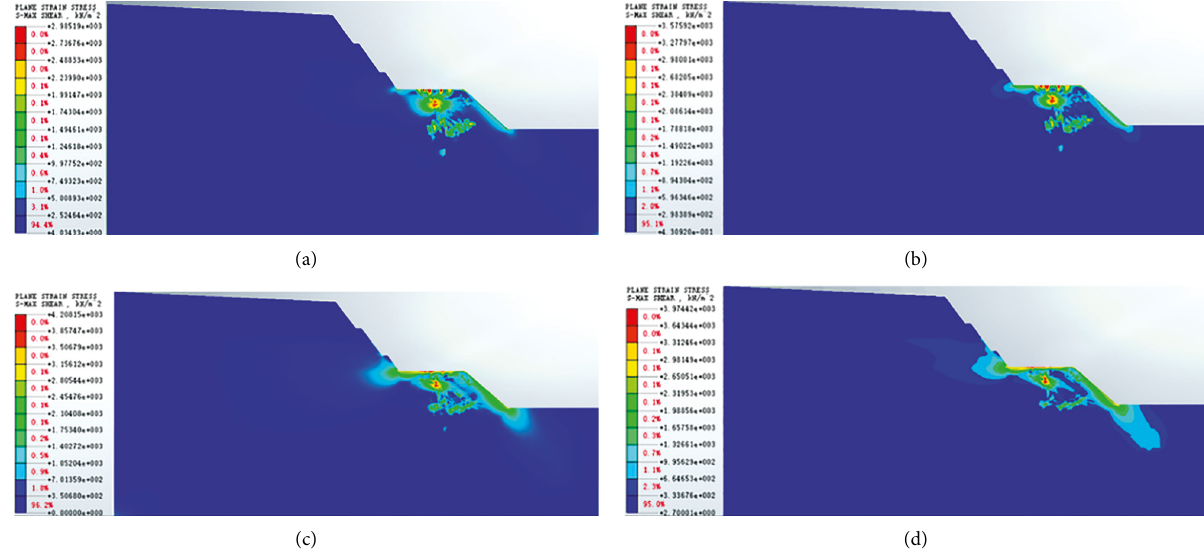
Figure 9: Stress nephogram after the third blasthole detonation. (a) 150 ms. (b) 155 ms. (c) 170ms. (d)